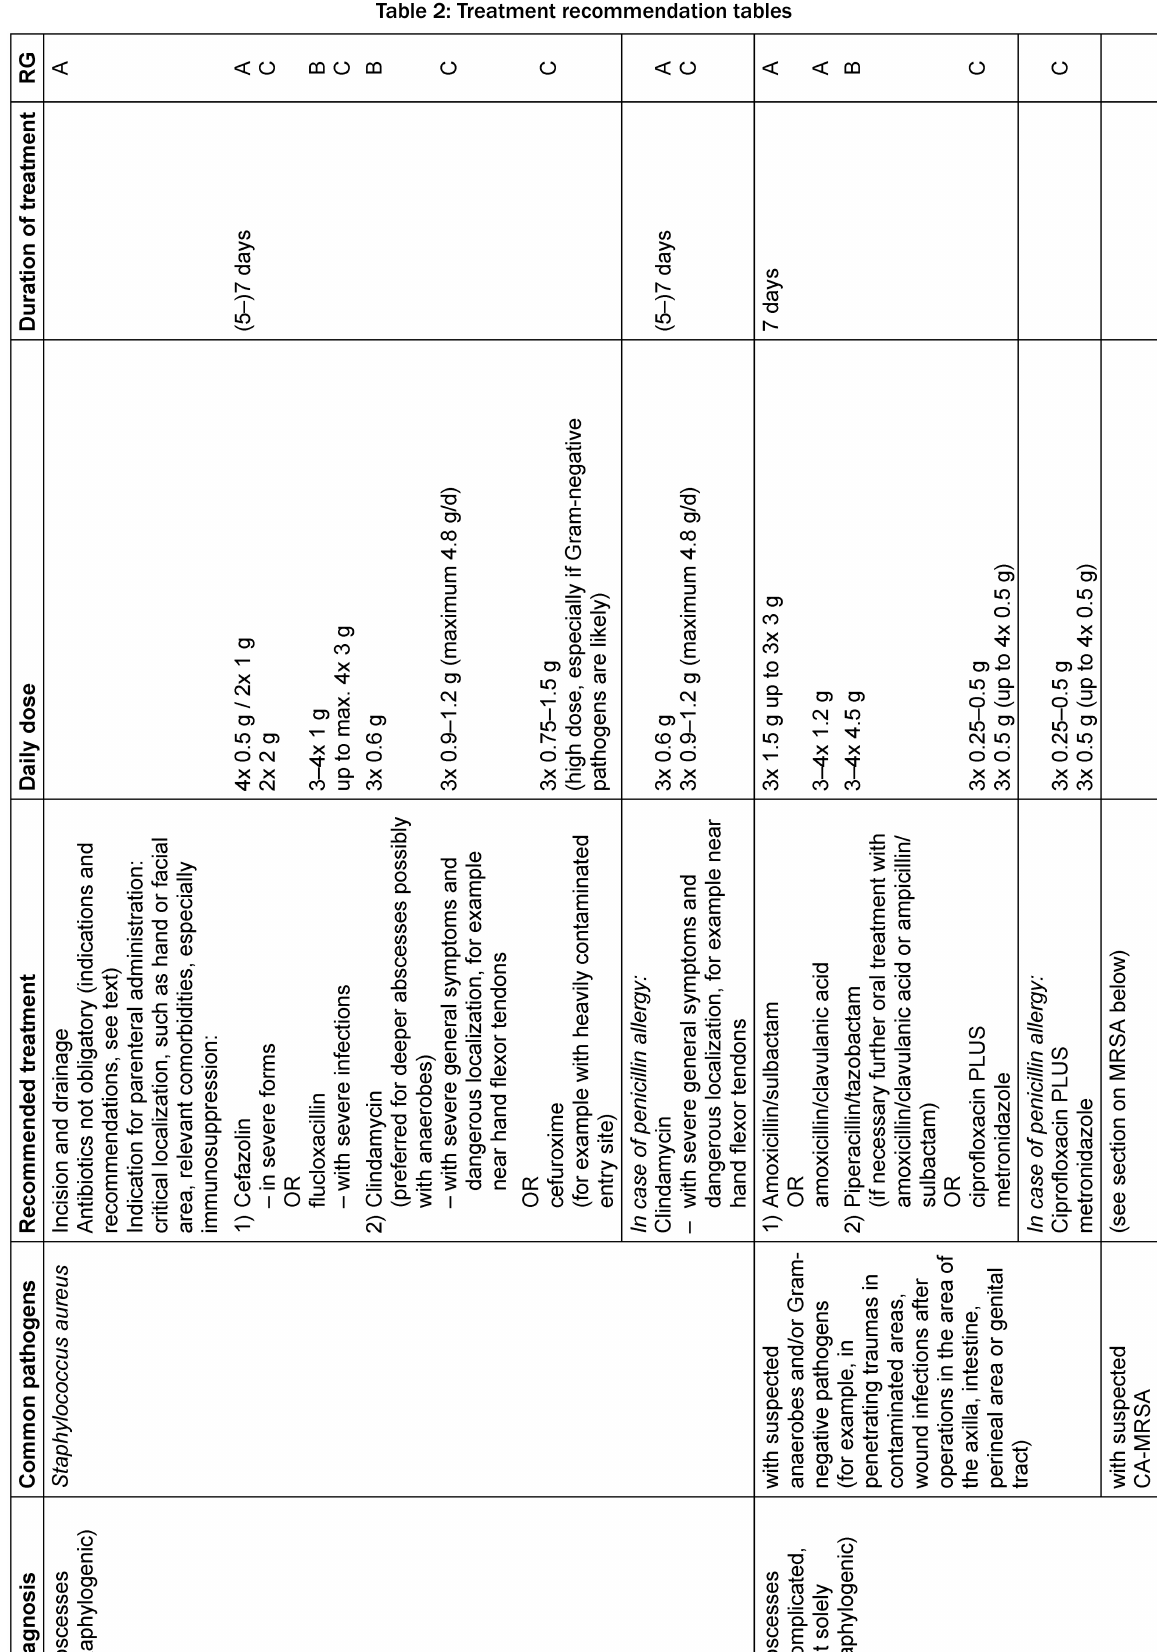
Table 2: Treatment recommendation